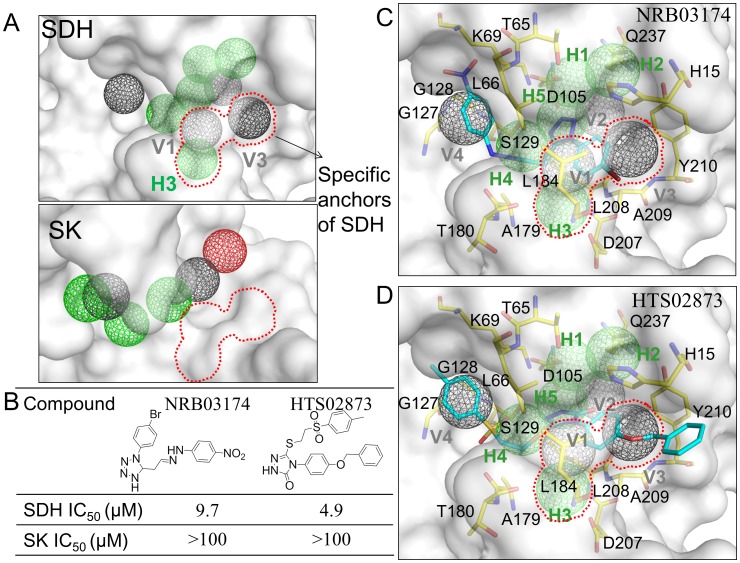
Specific anchors and selective inhibitors of shikimate dehydrogenase (SDH).(A) Specific anchors of SDH. The specific site includes these anchors H3, V1, and V3. (B) Compound structures and IC50 values of two selective inhibitors. Docking poses of these two selective inhibitors (C) NRB03174 and (D) HTS02873.